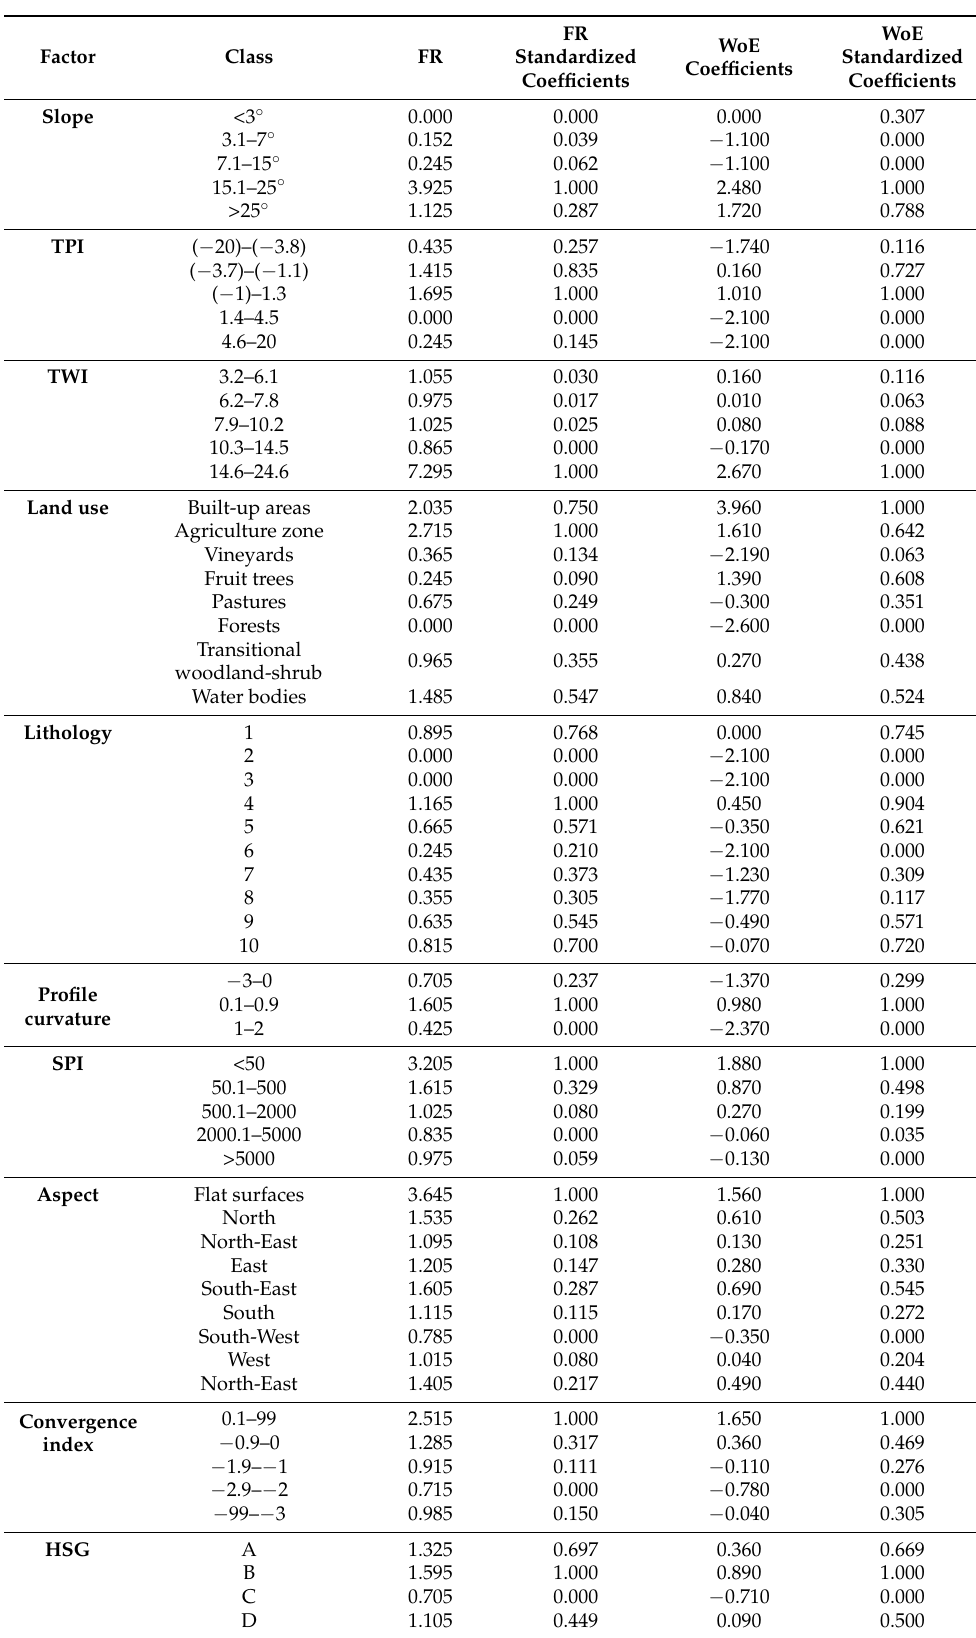
Table 1. FR and WOE